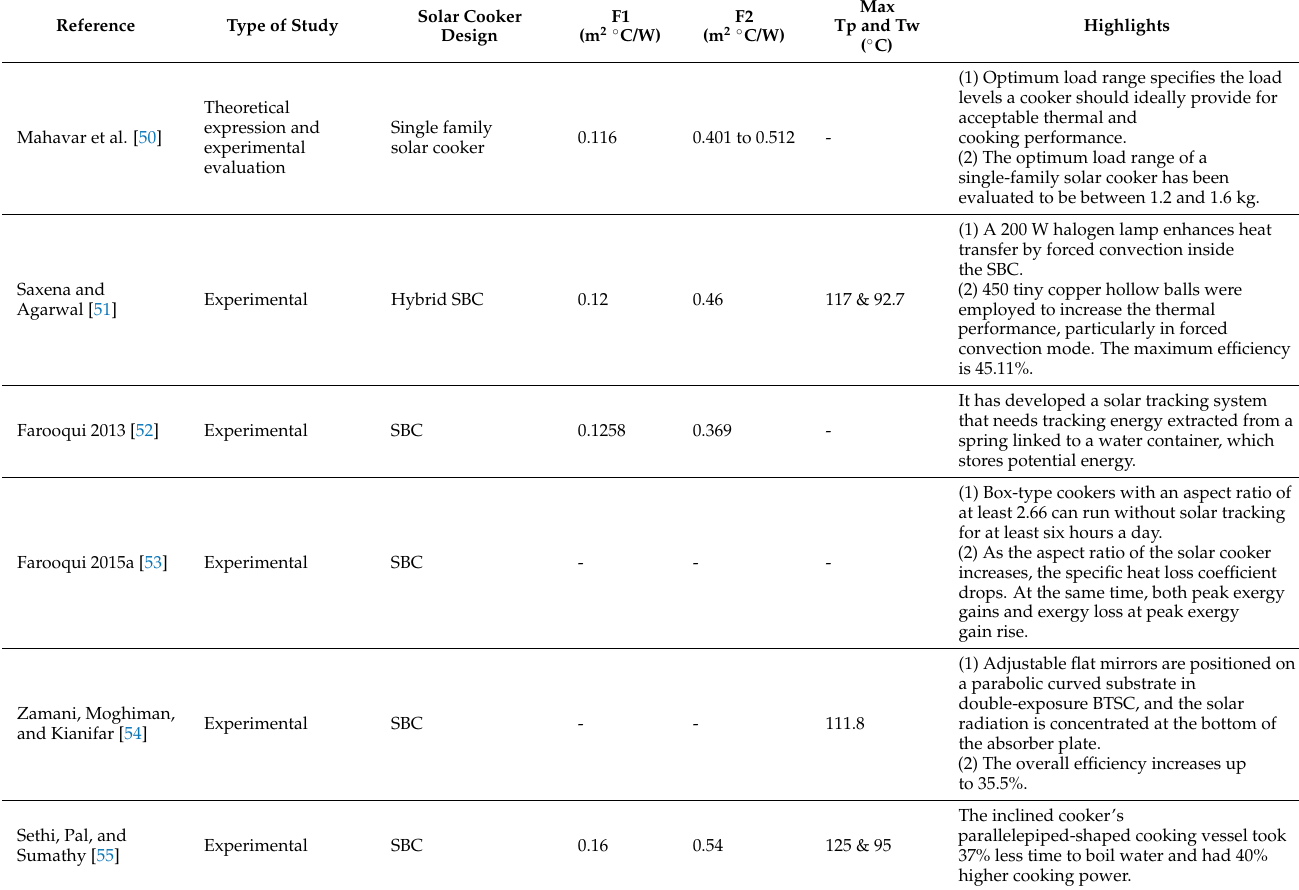
Table 1. A summary of the studies for Solar box-type